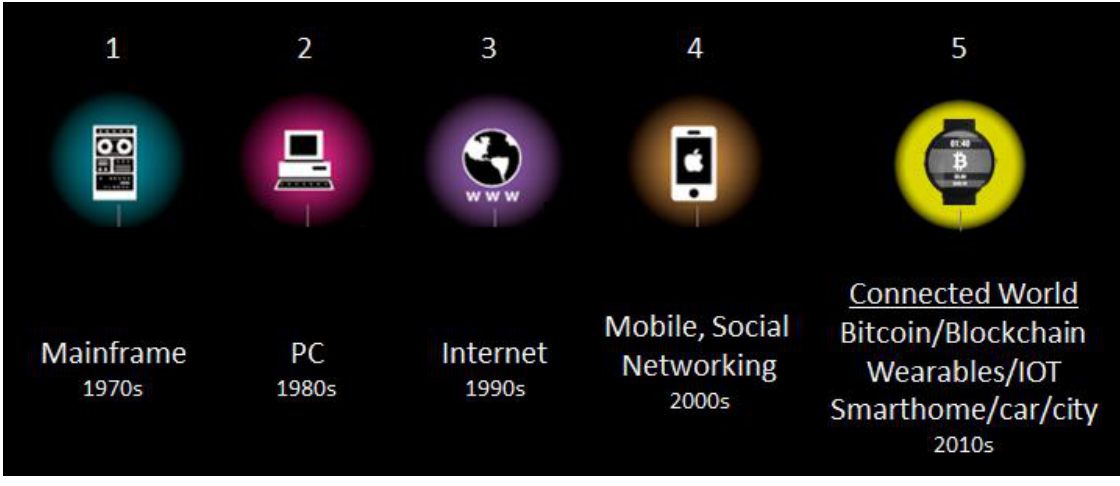
Figure 2. Disruptive Computing Paradigms: Mainframe, PC, Internet, Social-Mobile, Connected World. Expanded from O’Reilly Radar (by Mark Sigal)